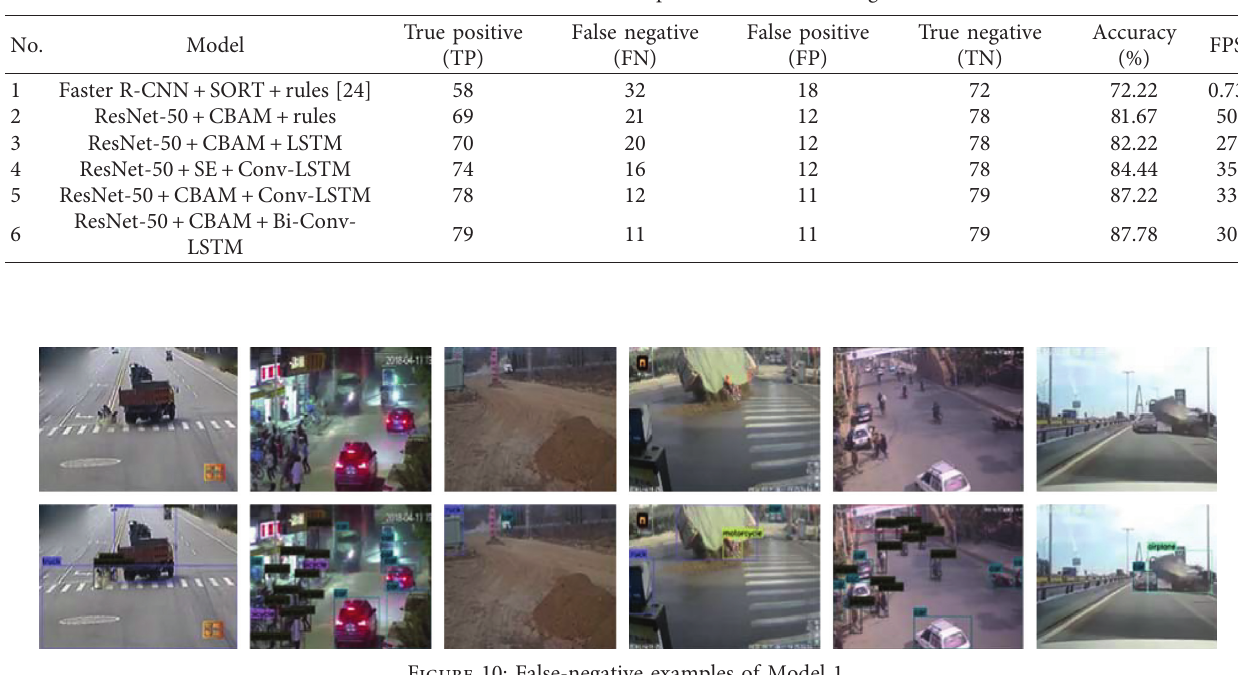
Table 2: Crash detection models’ performances on testing set.